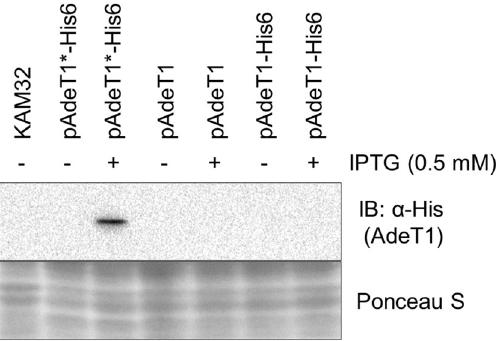
Figure 2. Immunoblotting analysis of AdeT1 expression in E. coli KAM32 from three plasmids. The pAdeT1 plasmid was constructed as described before 35 , while pAdeT1-His6 contains a 6 × Histidine tag on the C terminus of the protein encoding gene. The pAdeT1*-His6 plasmid is a similar construct, with the adeT1 gene in frame with a start codon and with a 6 × Histidine tag on the C terminus. Cells were induced with 0.5 mM IPTG at OD 600 ~ 0.6. After 2 h at 37 °C, samples were taken for analysis. A full-length version of the immunoblot is provided in Supplementary Fig. S3.